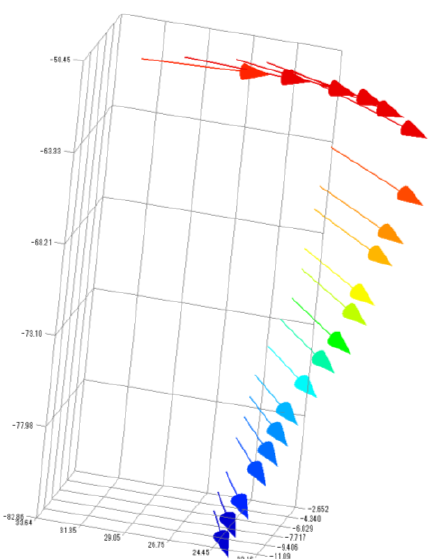
Figure 8. Calculated motion on the surface of the target